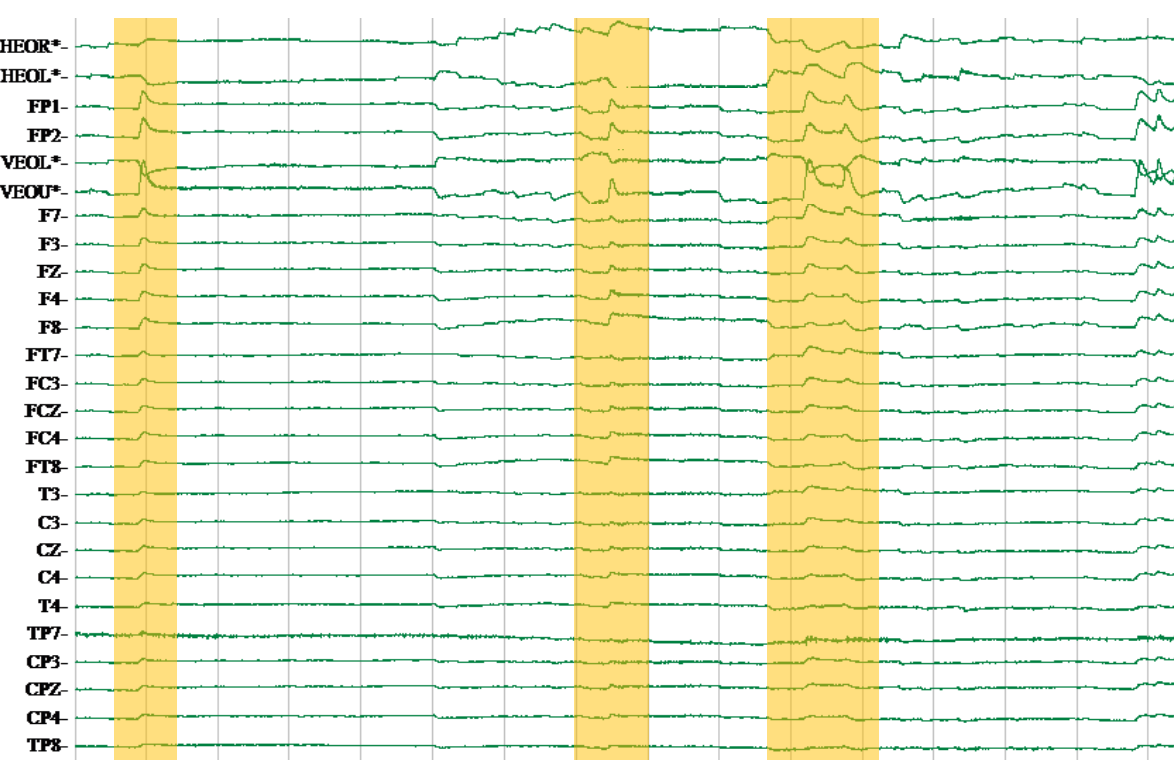
Figure 5. Artifact Removal: Before and After Processing. Signals were processed to remove potential artifacts from facial and eye muscle contractions using spatial and frequency-based